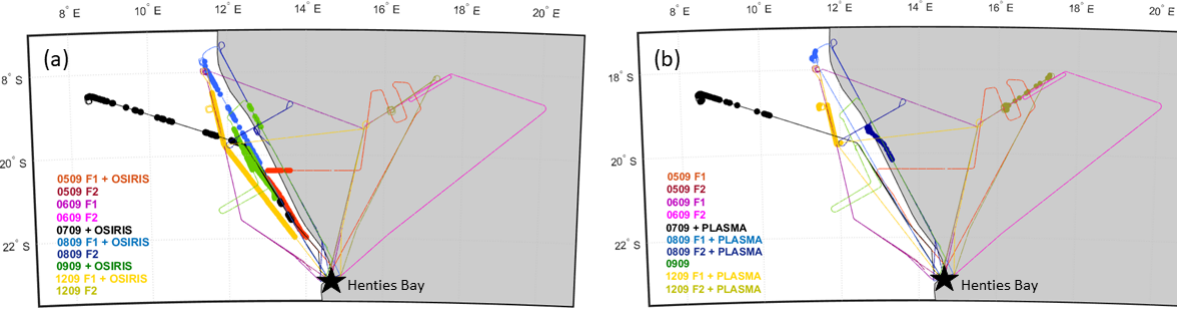
Figure 1. Flight tracks of the 10 flights of the AEROCLO-sA campaign over the Namibian coast in September 2017. Circles indicate the (a) OSIRIS inversion locations and (b) PLASMA-2 measurement locations at low flight altitudes.